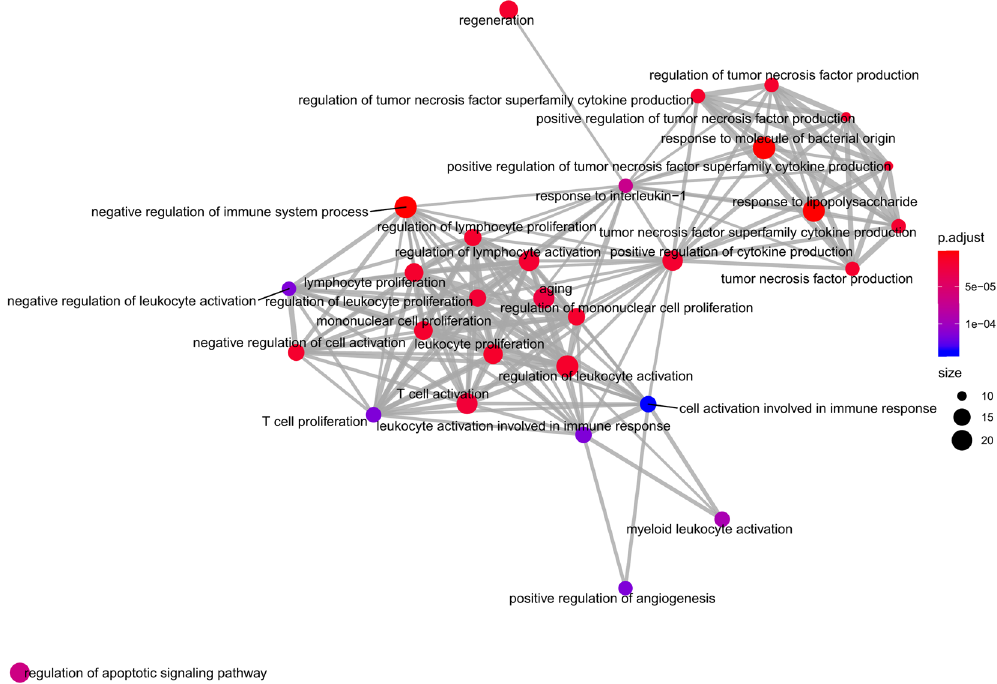
Figure 9. The GO interaction network of DEMs in Cerebral